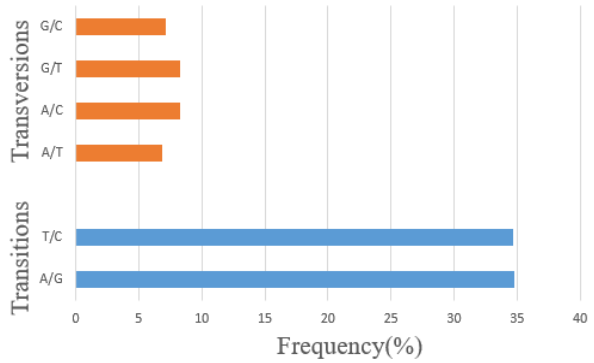
Figure 1. The statistics of mutation type of single nucleotide polymorphisms (SNPs). Note: The proportion of translation (ts) mutations and transversion (tv) mutations meet the 3 to 1